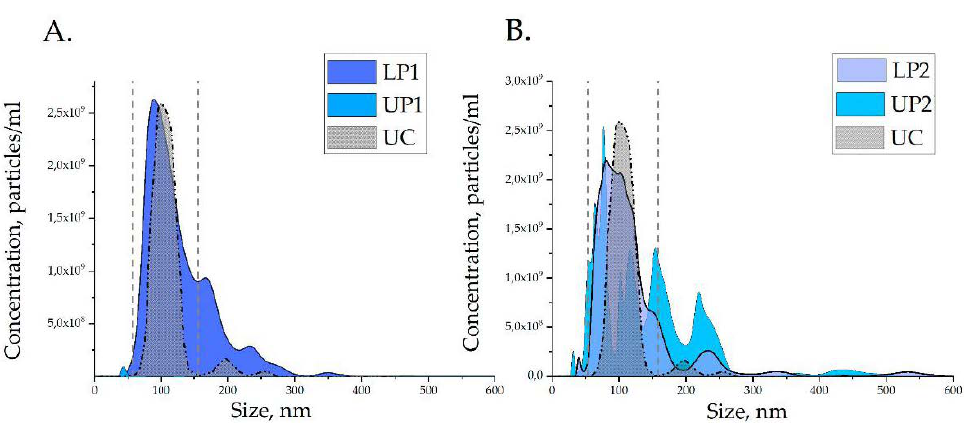
Figure 4. Nanoparticle size distribution in PTPS phases and extracellular nanovesicles isolated by ultra-centrifugation (UC-ENV) measured by nanoparticle tracking analysis NTA. ( A ) First phase separation; ( B ) second phase